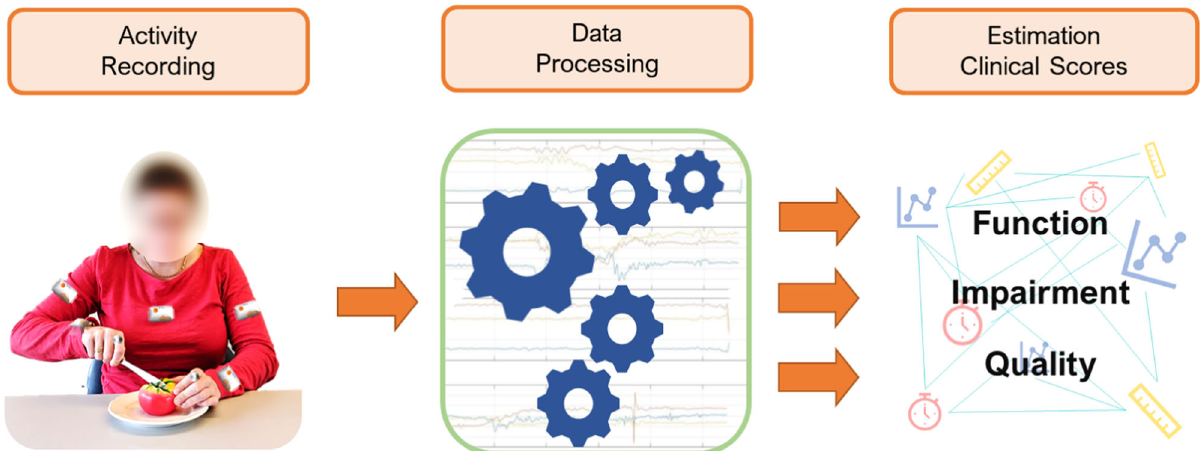
Fig. 1 Schematic representation of the proposed approach. Data are collected using wearable sensors positioned on the upper limbs during the performance of functional tasks. Sensor data are fed to machine learning-based algorithms to derive estimates of clinical scores relevant to different ICF